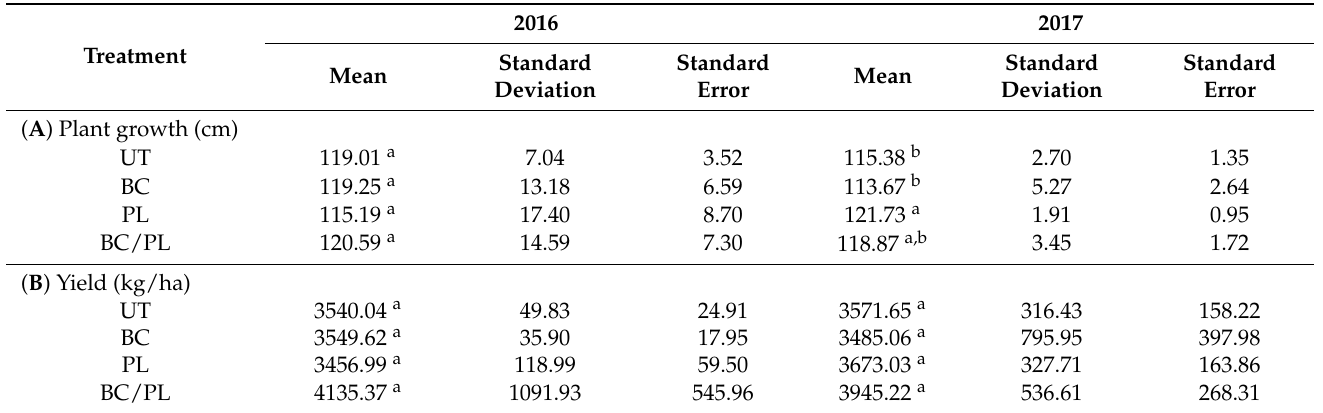
Table 3. Effects of soil treatments on the soybean growth and yield in 2016 and 2017.